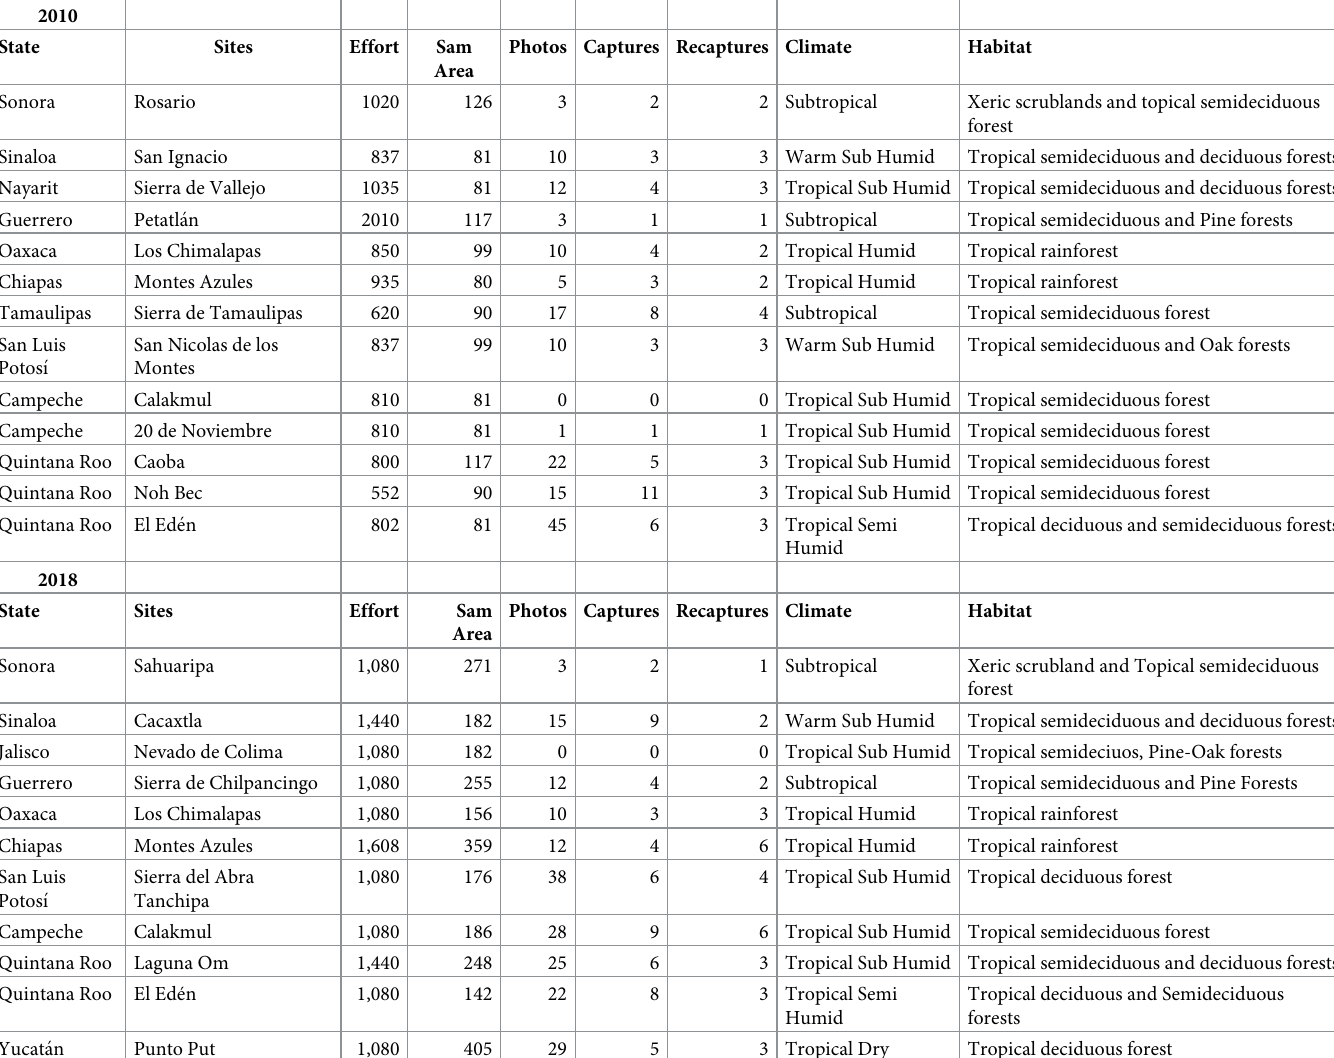
Table 1. Summary data and statistics for the 2010 and 2018 jaguar censuses in